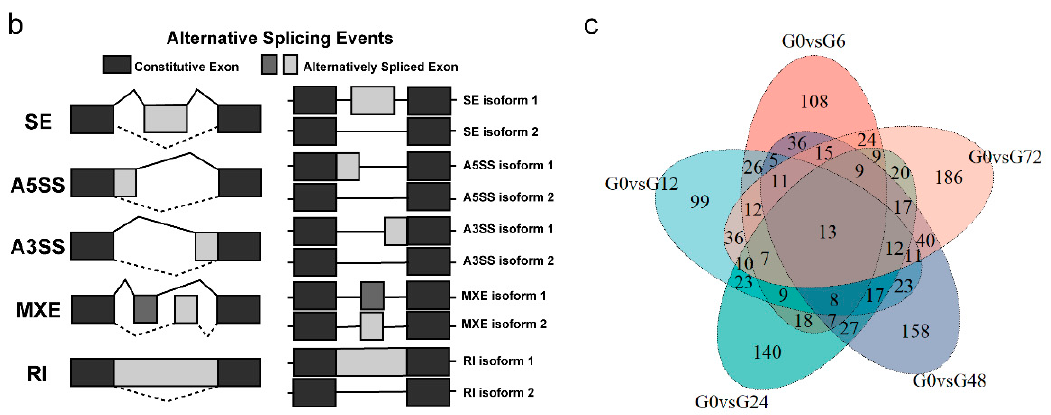
Figure 1. Differential alternative splicing events identified in Arabidopsis thaliana roots challenged with Ralstonia solanacearum . ( a ) Model of root symptoms following GMI1000 infection in our previous study. NS = no symptom, RH = root hair emergence, PC = primary root growth arrest and cell death and LR = lateral root emergence. ( b ) Each type of alternative splicing (AS) events detected by rMATs in our RNA-seq data: skipped exon (SE), alternative 5 ′ splice site (A5SS), alternative 3 ′ splice site (A3SS), mutually exclusive exons (MXE) and retained introns (RI). Each type of AS event produces two isoforms, namely isoform 1 and isoform 2, which are identified and qualified by junction reads only. ( c ) Comparison of differential alternative splicing genes (DSGs) at different time points.